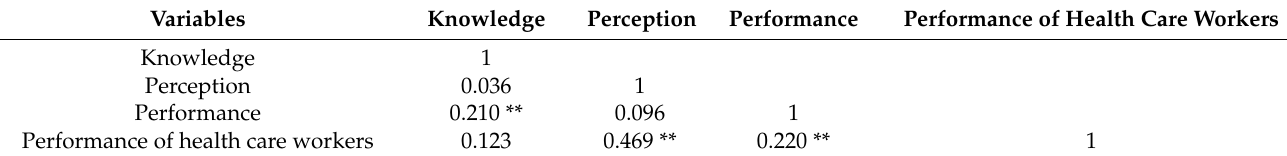
Table 3. Pearson’s correlation